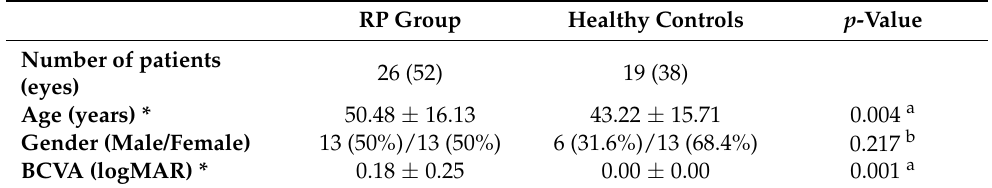
Table 1. Demographic and clinical characteristics of patients with retinitis pigmentosa and controls. RP Group Healthy Controls p -Value